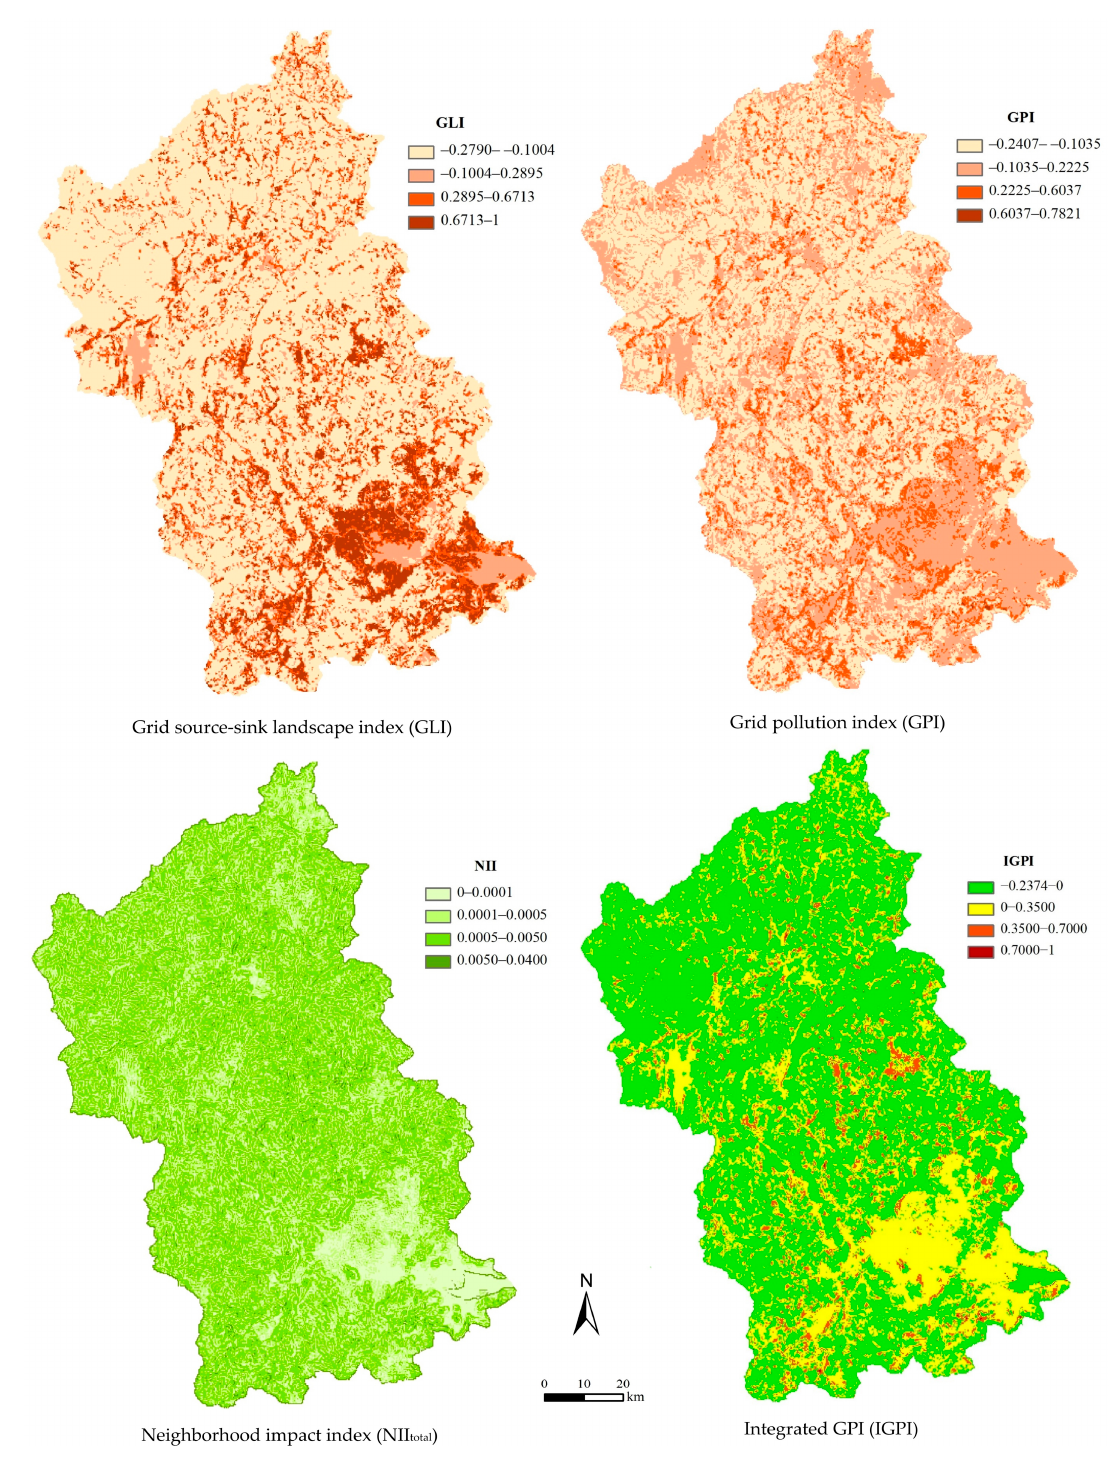
4 Figure 4. The results of NPS pollution CSAs identification calculation in the Jiulong River